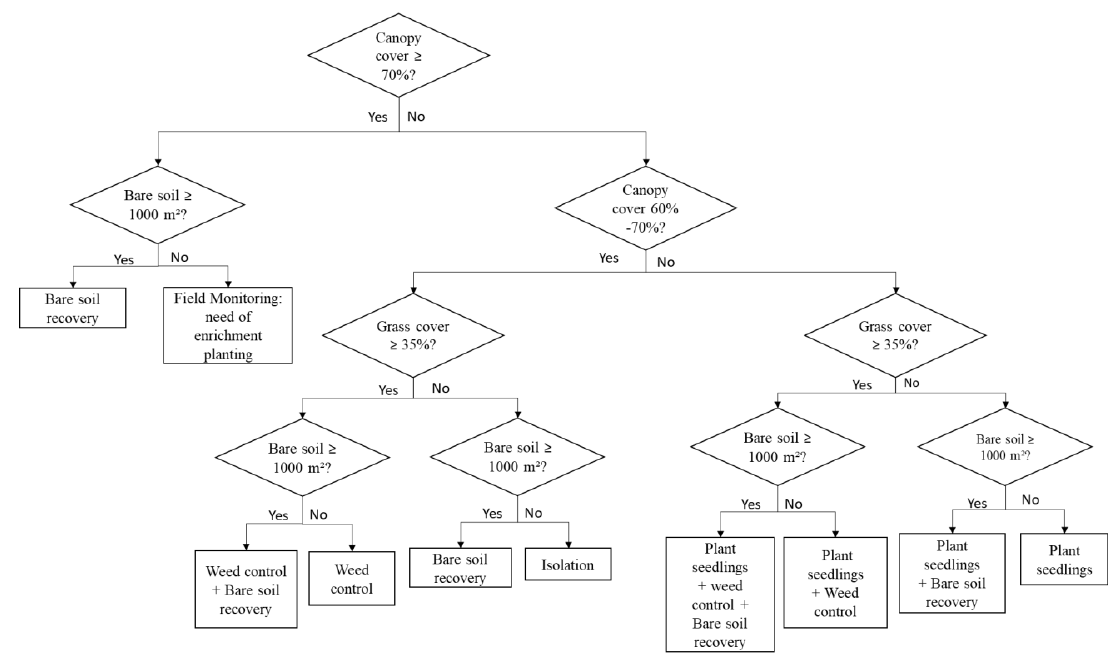
Figure 3. Decision-making flowchart to generate management recommendations from the reference values of indicators. Plant seedlings: From the “filling group” list. Weed control: Weeding, mowing.